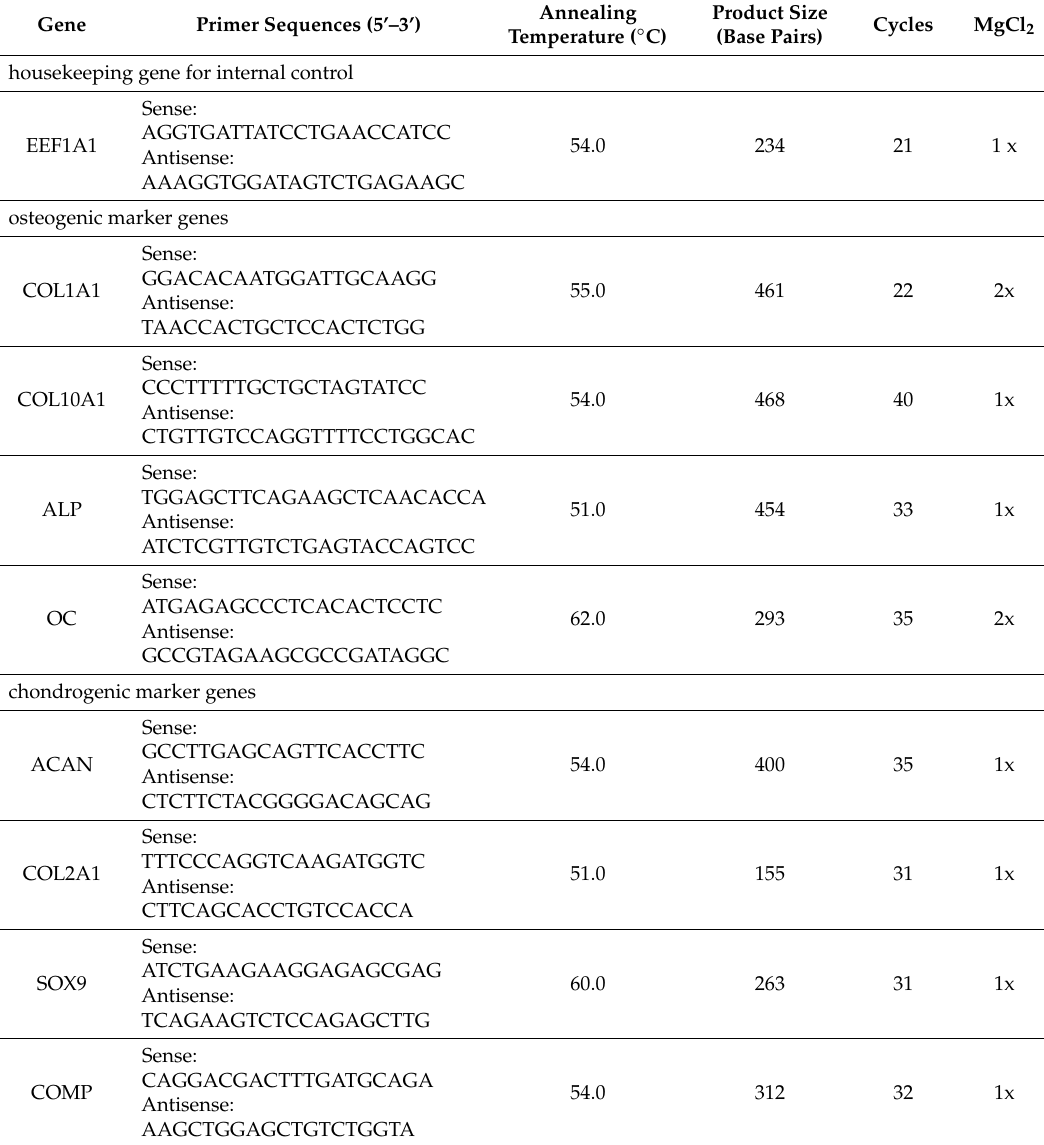
Table 1. Primer sequences and product sizes for semiquantitative